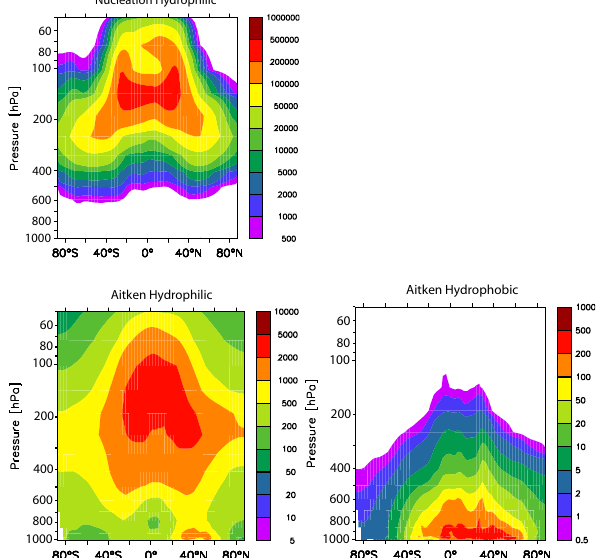
Fig. 3. As Fig. 2 but for the (top left) accumulation hydrophilic, (top right) accumulation hydrophobic, (bottom left) coarse hydrophilic and (bottom right) coarse hydrophobic modes.